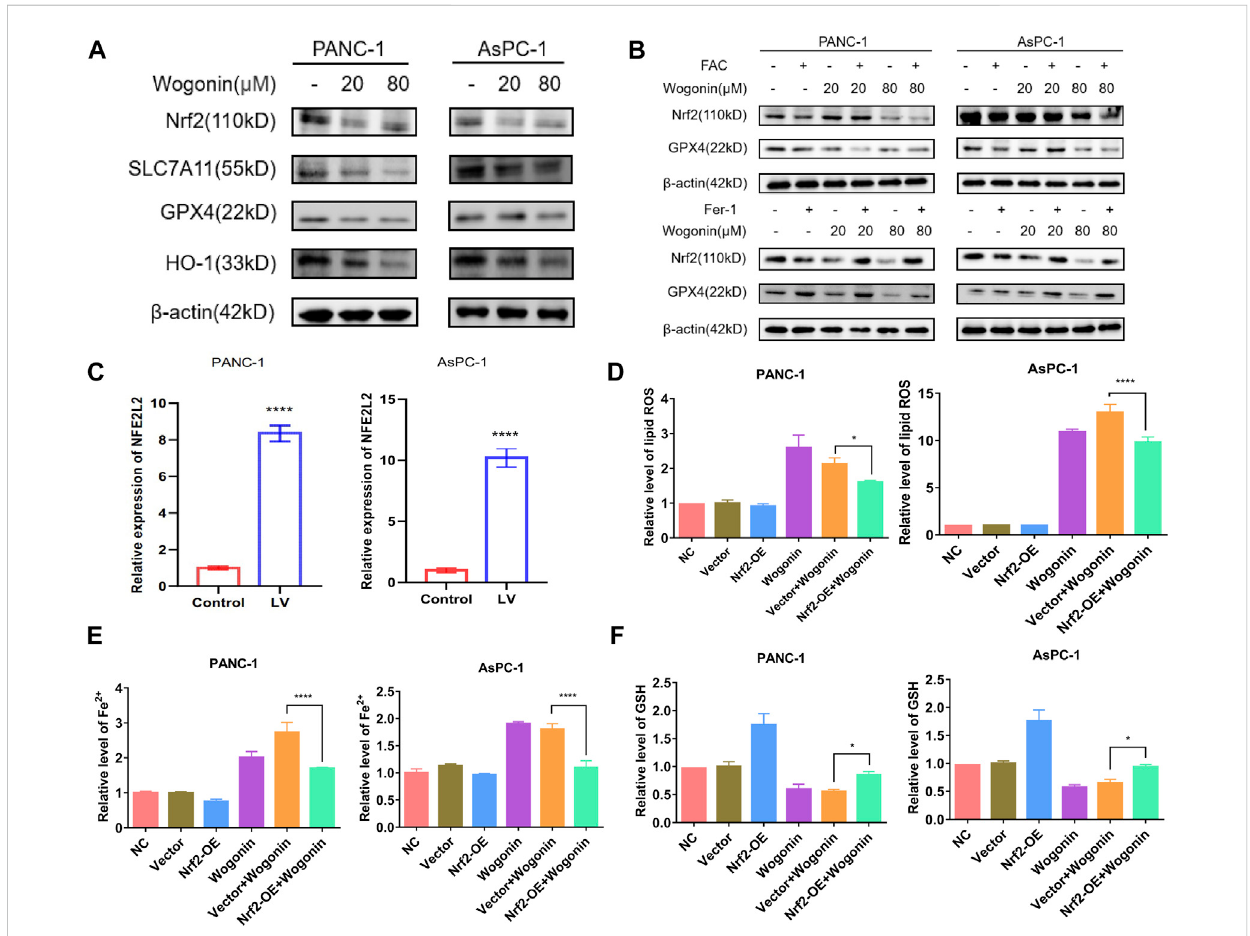
FIGURE 6 Overexpression of Nrf2 contributed to wogonin-induced ferroptosis in pancreatic cancer cells. (A) Western blotting proved that wogonin downregulated the expression of ferroptosis relate protein, in a dosage-dependent manner. (B) Effect of ferroptosis inducer or inhibitor on wogonin regulatory protein. (C) The overexpression of NFE2L2 mRNA was detected by RT-qPCR. (D) Wogonin-induced accumulation of lipid peroxidation was prevented when Nrf2 was overexpression. (E) Overexpression of Nrf2 prevented wogonin-induced overproduction of Fe 2+ . (F) Wogonin-induced repressionofGSHwasimprovedwhenNrf2wasoverexpression.*: p < 0.05versuscontrolgroup;****: p < 0.0001versusthegrouptreatedwithwogonin